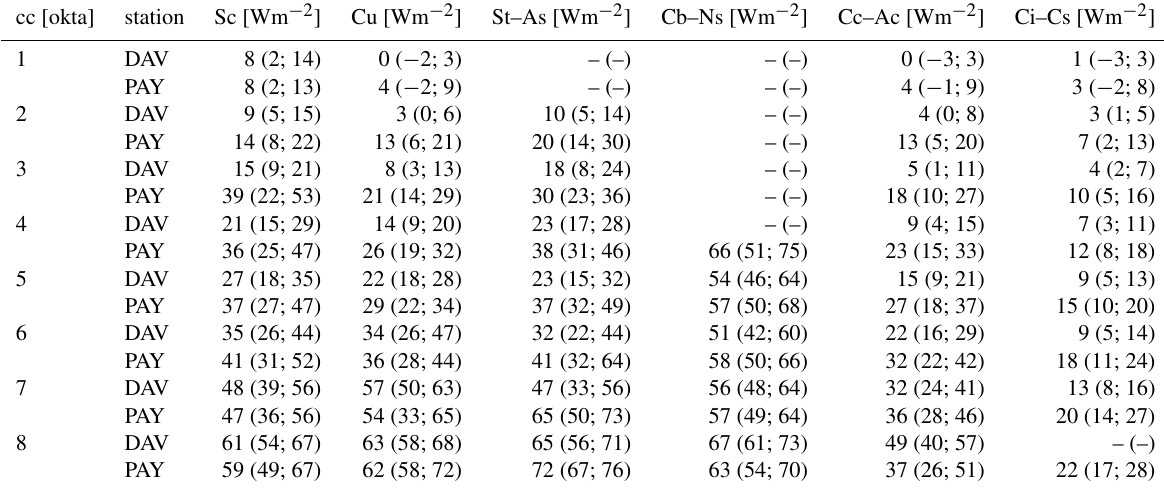
Table 1. Median and interquartile range of longwave cloud radiative effect values [Wm − 2 ] per okta for the two stations Davos (DAV) and Payerne (PAY) and six cloud classes stratocumulus (Sc), cumulus (Cu), stratus–altostratus (St–As), cumulonimbus–nimbostratus (Cb–Ns),